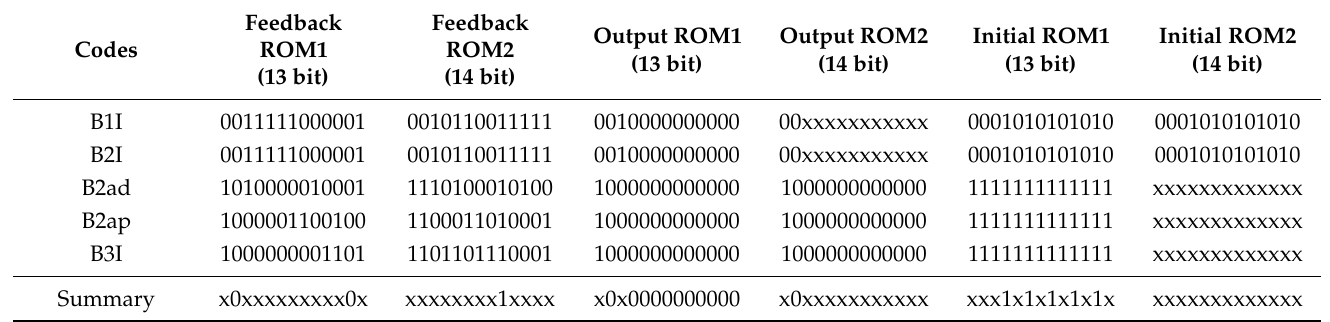
Table 3. The fixed parameters of code generators for BDS